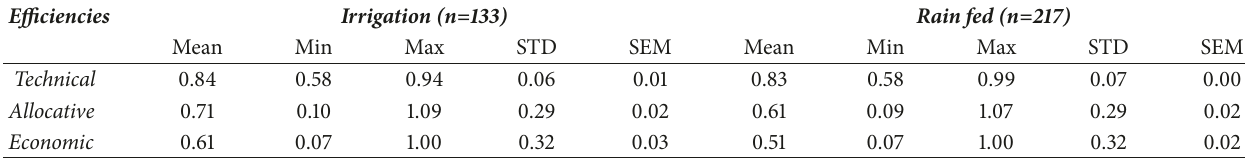
Table 5: Average efficiency measures of the irrigation and rain fed